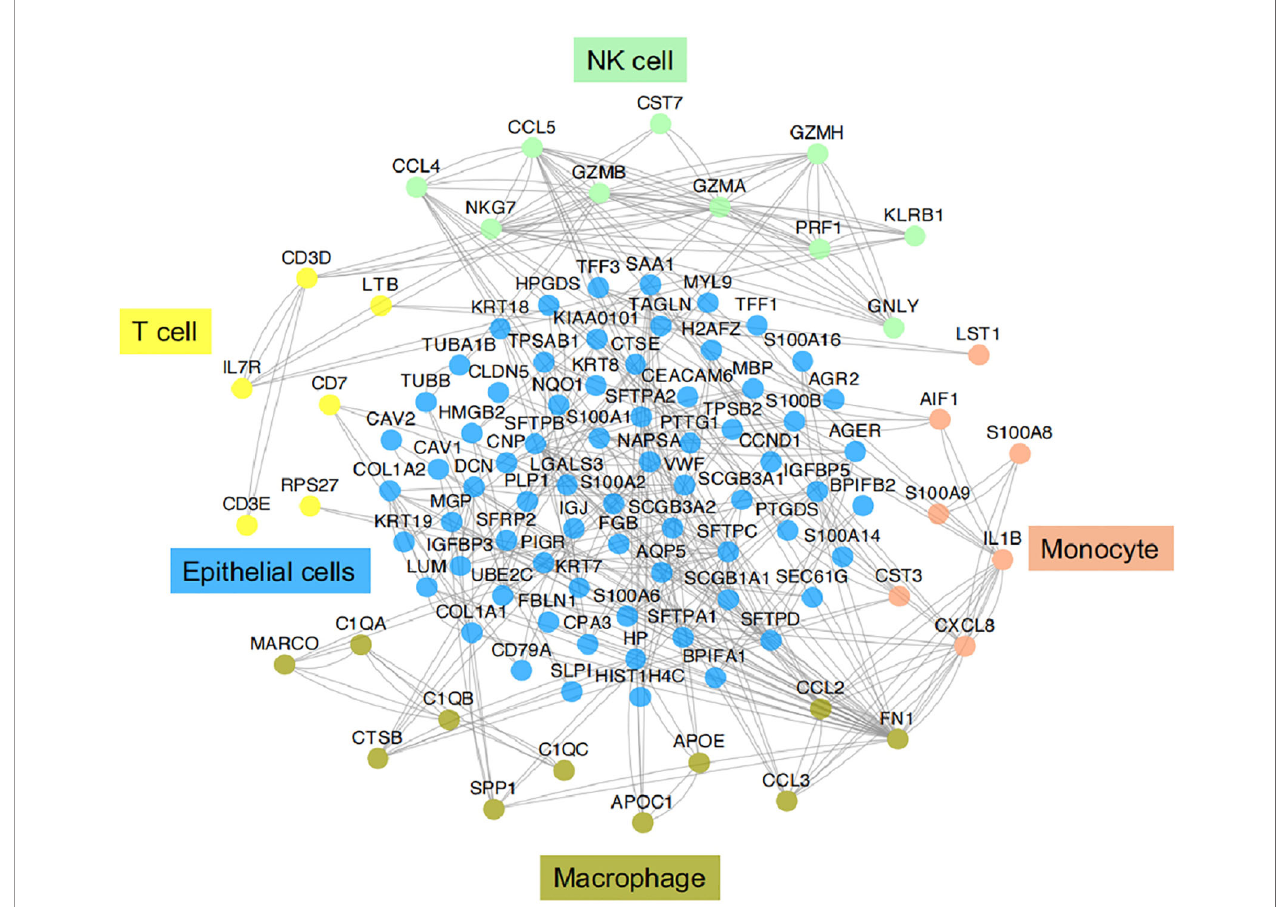
FIGURE 3 | Functional association networks of signature genes between different cell types of IICs in TME of LUAD. Using StringDB with protein-protein interaction data showed functional association networks between signature genes speci fi c to stromal cell of TME in